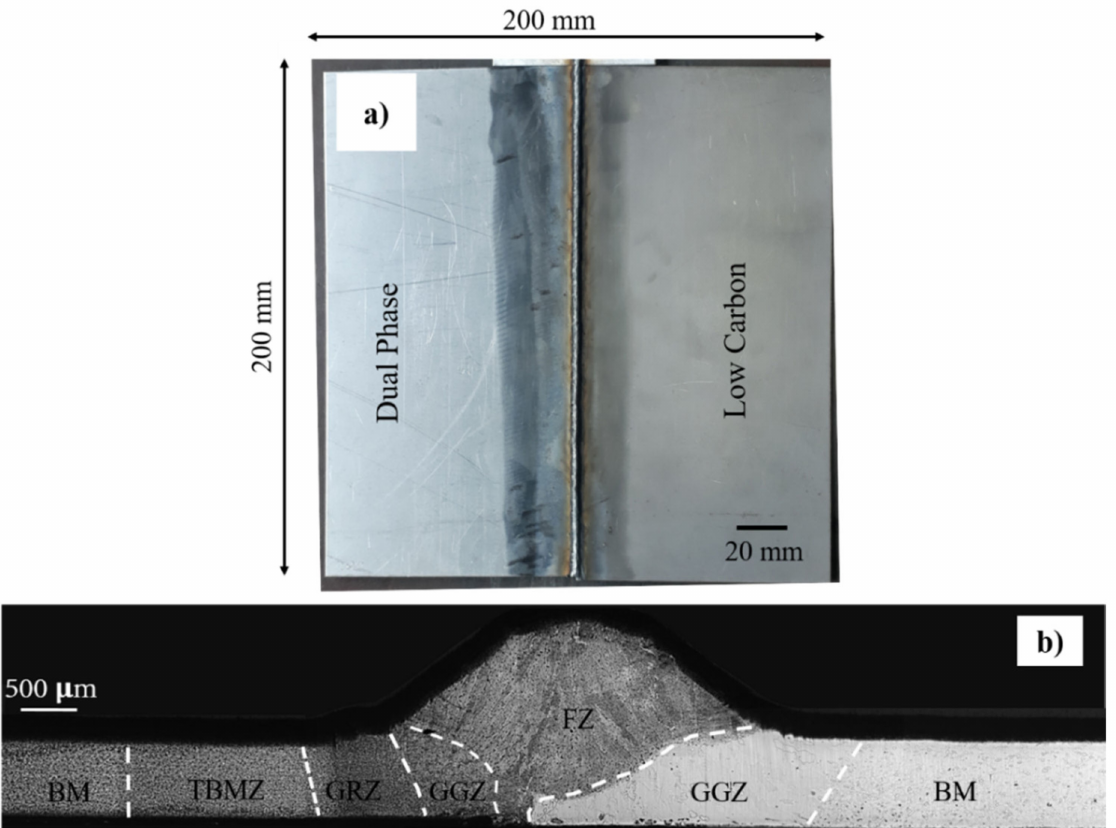
Figure 12. Dissimilar weld of LC and DP steels: ( a ) Top view and ( b ) transversal section showing different welding zones. FZ–fusion zone, GGZ–grain growth zone, GRZ–grain refinement zone, TBMZ–tempering base metal zone, and BM–base metal.